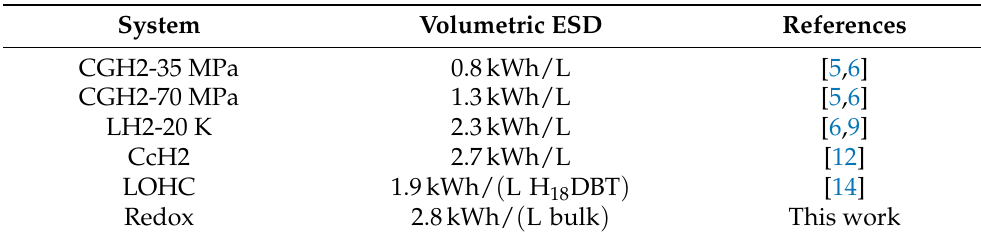
Table 1. Summary of the most widely used hydrogen storage systems with their volumetric energy storage densities (ESDs). CGH2, compressed gas storage of hydrogen; CcH2, cryo-compressed hydrogen; LOHC, liquid organic hydrogen